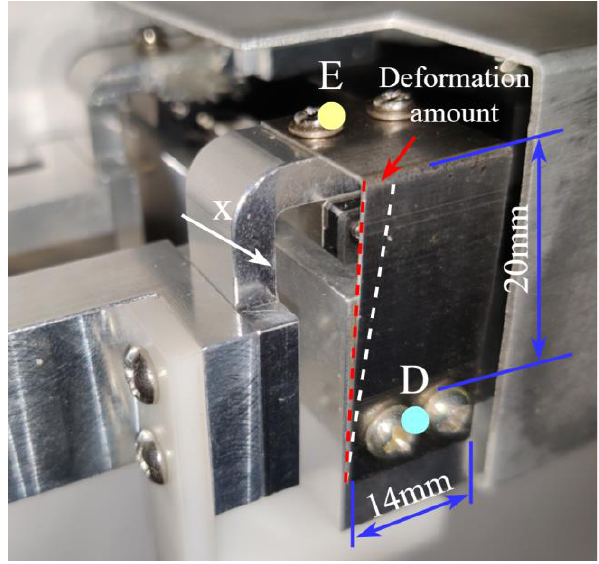
Figure 5. Position of elastic actuator.